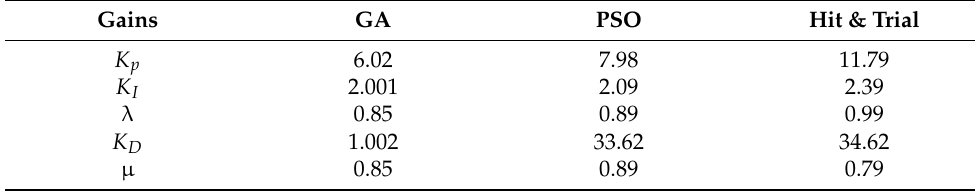
Table 4. PID Controller Parameters (Fractional Order) in terms of